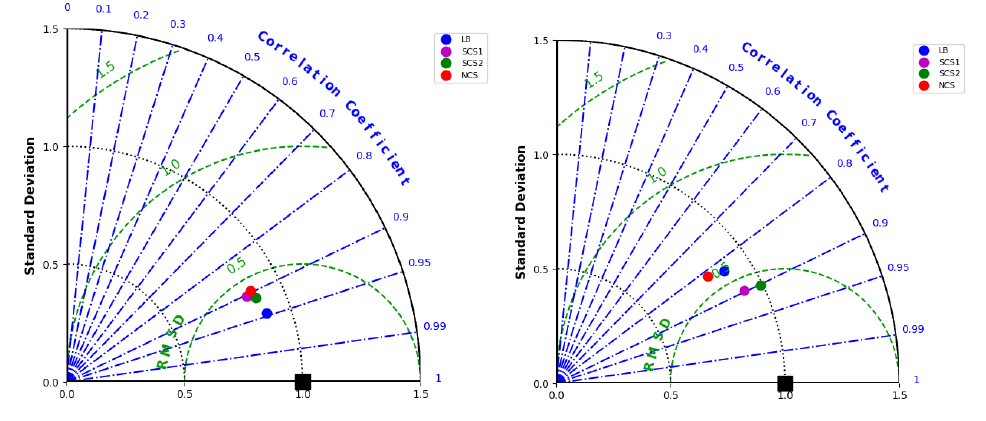
Figure 8. Taylor Diagrams for the training on the left and testing on the right comparing the results from the different sites.